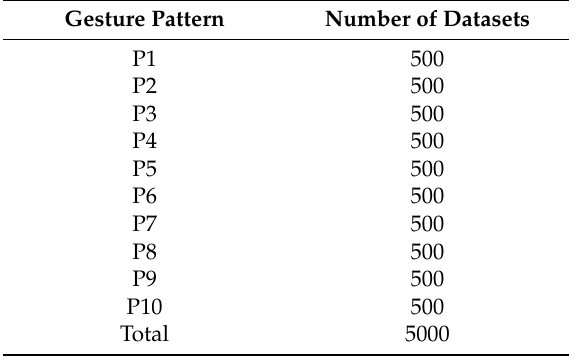
Table 2. The number of a dataset according to gesture pattern types. Gesture